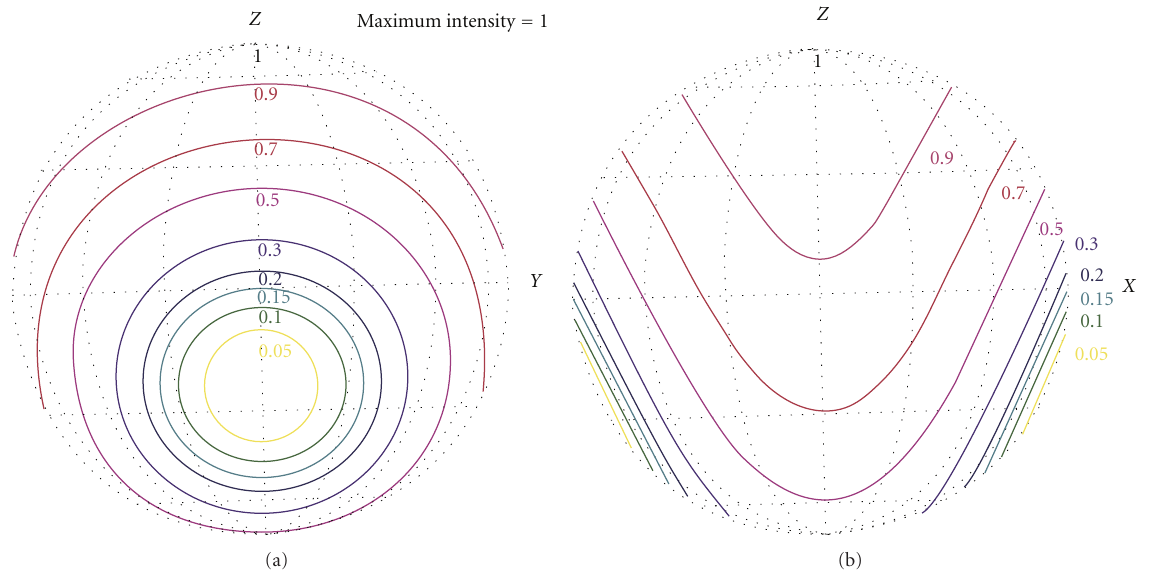
Figure 8: Constant amplitude curves of the surface current density on the surface of the spherical radiator drawn in Figure 7.